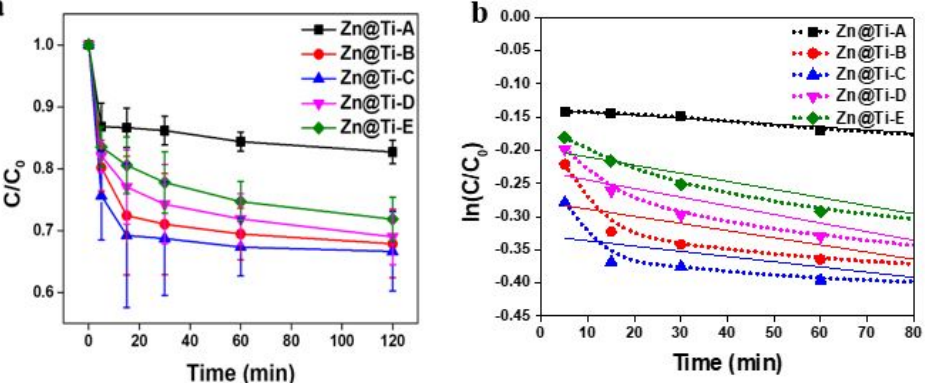
Figure 5. Photocatalytic degradation of methylene blue ( a ) and kinetics curves for photocatalytic degradation ( b ). Table 2. Comparison of similar research with this work. Reaction Time